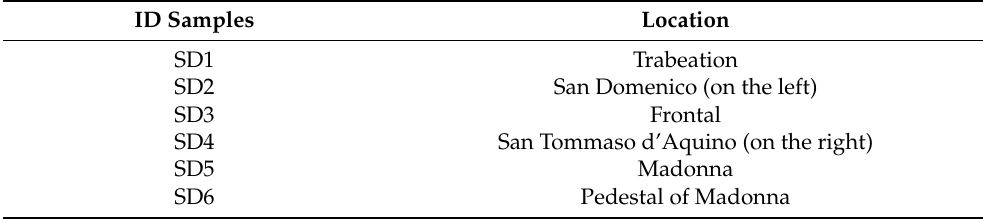
Table 1. Marble samples taken from the “Madonna della Febbre”